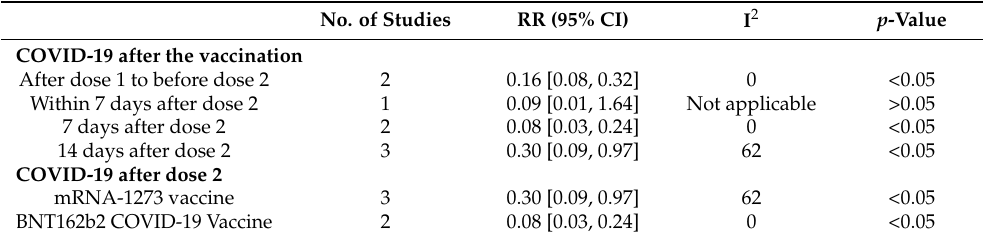
Table 12. COVID-19 was diagnosed after vaccination in the vaccine group versus the control group. No. of